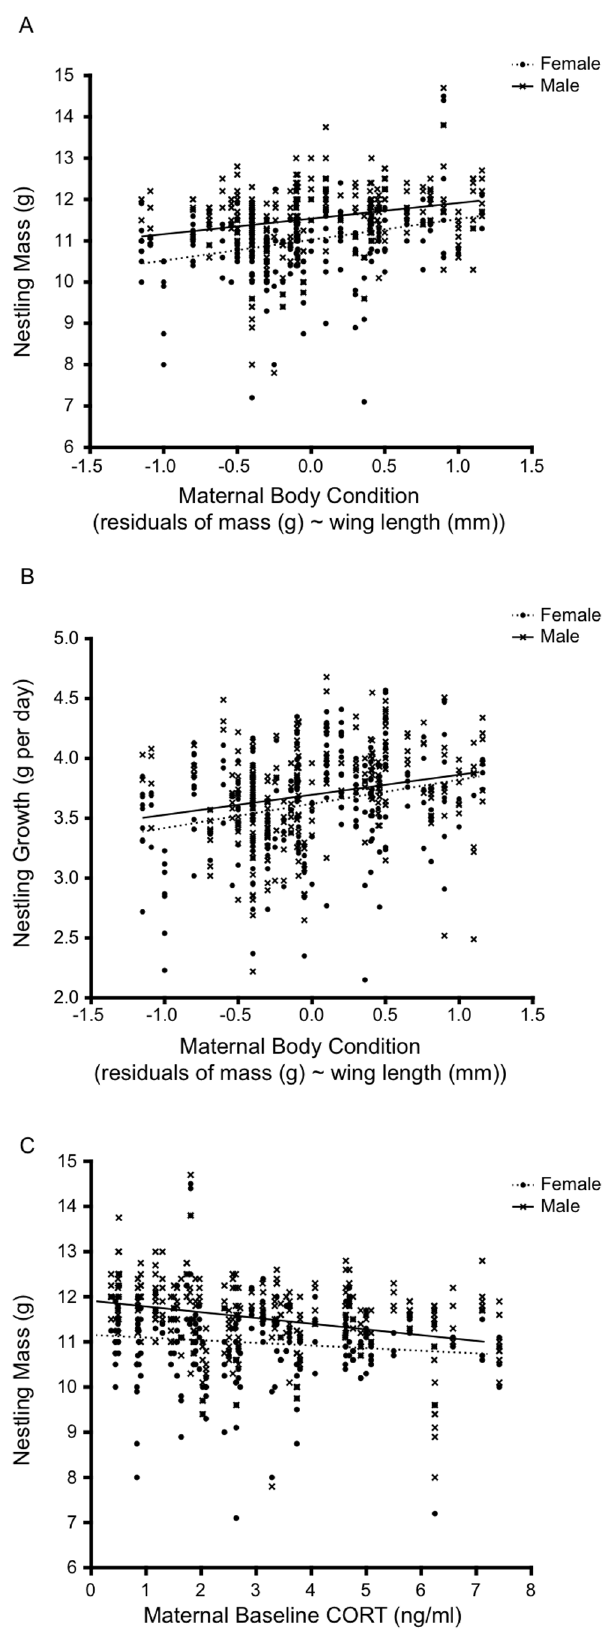
Figure 3. The relationship between a) maternal body condition and nestling mass on day 14 after hatching, b) maternal body condition and nestling growth rate, and c) maternal baseline CORT and nestling mass on day 14 after hatching from 2008– 2010 ( n =chicks: 520, broods: